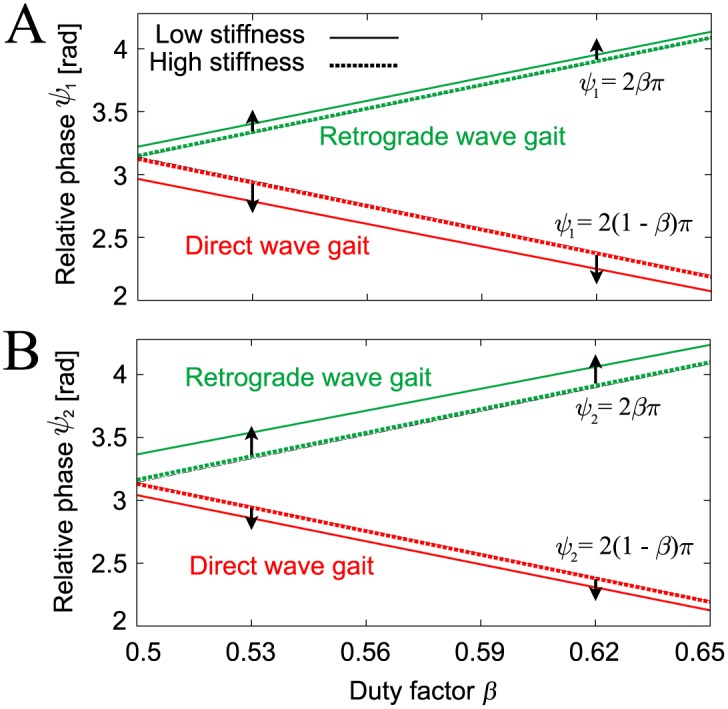
Relative phases A (ψ1) and B (ψ2) of the direct and retrograde wave gaits from the simple model.The relative phases are derived with both high stiffness (d* K* = 50)(solid line) and low stiffness (d* K* = 5)(dashed line) for s*/a* = 0.3. When the stiffness decreases, the relative phases ψ1 and ψ2 move away from 2βπ and 2(1 − β)π in a similar manner to the robot model in Fig 9. In addition, the relative phases of each gait change smoothly with changes in locomotion speed (duty factor β), as per the simulation.